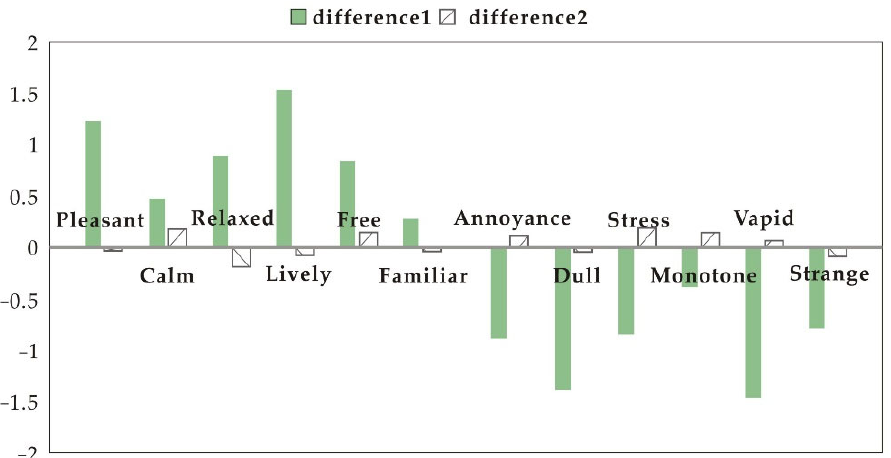
Figure 6. Differences in emotion perception (popular song). Difference 1: average difference in emotion perception between sample and no speakers; difference 2: average difference in emotion perception between sample and electronic speaker.